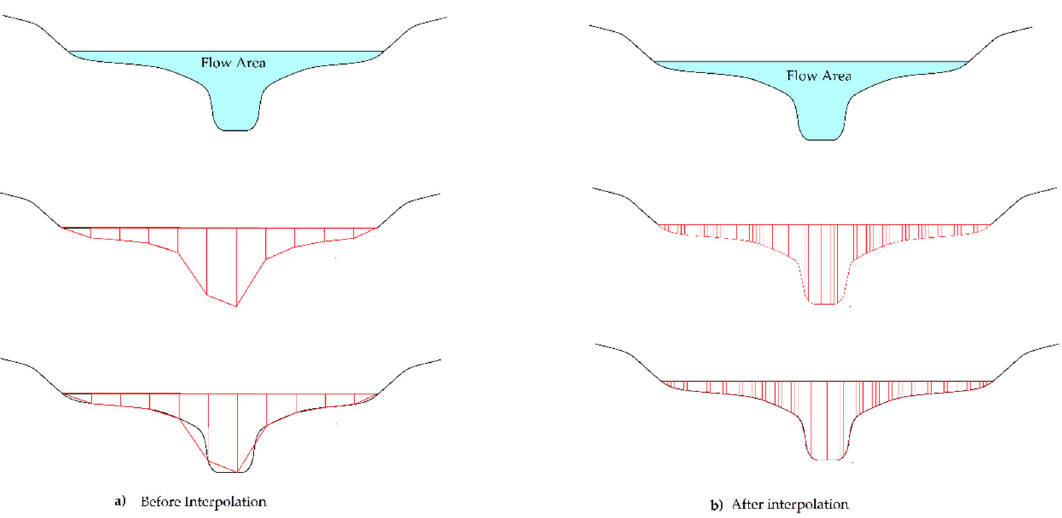
Figure 3. Scheme showing the cross-section area before ( a ) and after ( b ) the trapezoidal interpolation.